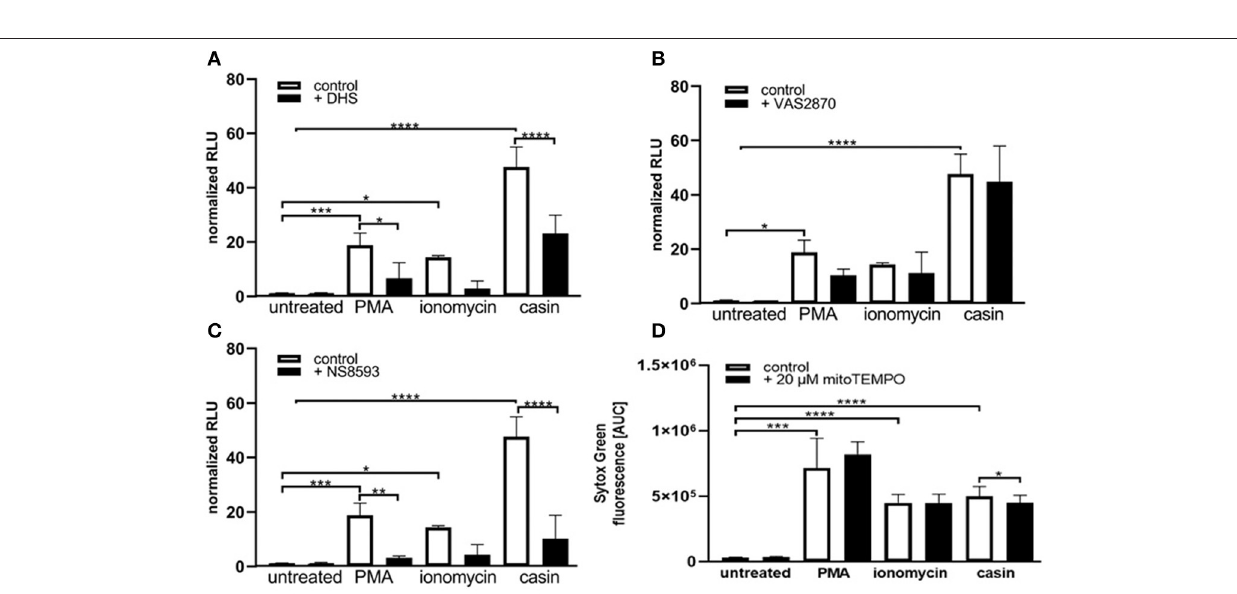
FIGURE 3 | Cdc42 inhibition induces NET formation dependent on PKC, SK-channels and mitochondrial ROS. Freshly isolated human neutrophils were pre-incubated with the Protein kinase C inhibitor DHS (4 µ M) (A), the NADPH oxidase inhibitor VAS2870 (20 µ M) (B) or the SK-channel inhibitor NS8593 (10 µ M) (C) for 4h at 37 ◦ C. The formation of NETs without stimulation (control), with 20nM PMA, 10 µ M ionomycin or with the Cdc42 inhibitor casin (10 µ M) was quantified by measuring the OD at 405nm of MPO-bound DNA, displayed as normalized relative light units (RLU). Data show mean ± SD of 3 independent experiments. **** p ≤ 0.0001, *** p ≤ 0.001, ** p ≤ 0.01, and * p ≤ 0.05. (D) Freshly isolated human neutrophils were pre-incubated with the mitochondrial ROS inhibitor mitoTEMPO (20 µ M) for 30min at 37 ◦ C and seeded into a fluotrac 96-well plate. Subsequently, 5 µ M Sytox Green was added to all samples and the formation of NETs without stimulation (control), with 20nM PMA, 10 µ M ionomycin or with the Cdc42 inhibitor casin (10 µ M) was detected over a period of 4h at 37 ◦ C by measuring the fluorescence of DNA bound Sytox Green. Quantification of NET release by calculating the area under the curve (AUC) from Sytox Green kinetic curves. Data show mean ± SD of